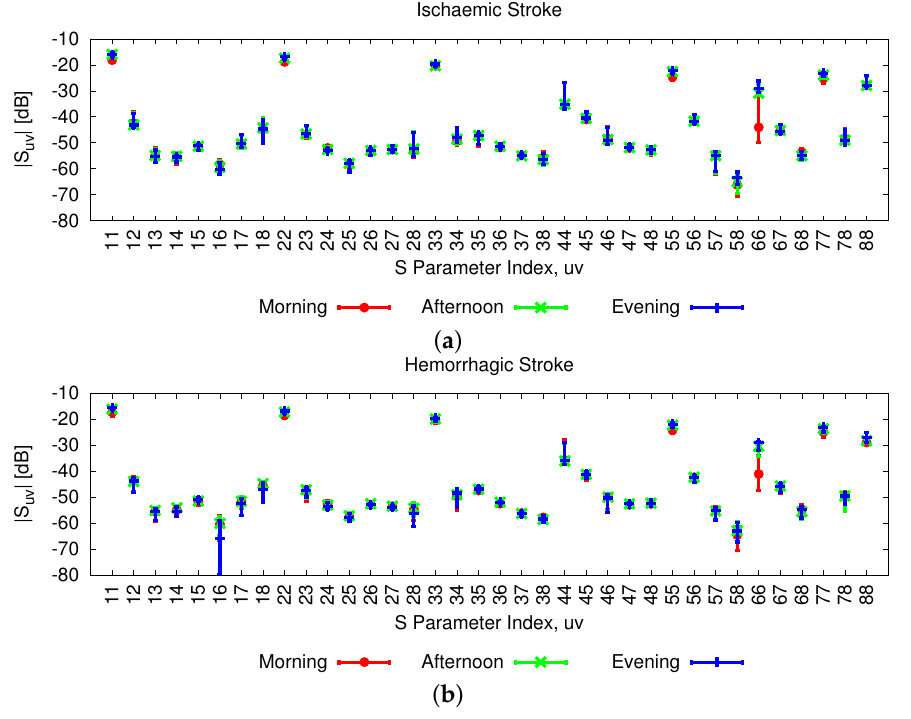
Figure 5. Experimental Assessment. ( V = 8, f 0 = 900 MHz, (cid:101) ε B = 41.8 ε 0 − j 0.97 S = 48.63 ε − j 1.28 )—Minimum, maximum, and average value of the scattering coefficients (cid:101) ε 0 H 2 π f 0 measured in three different moments of a single day (i.e., morning, afternoon, and evening) with ( a ) an ischaemic and ( b ) an hemorrhagic